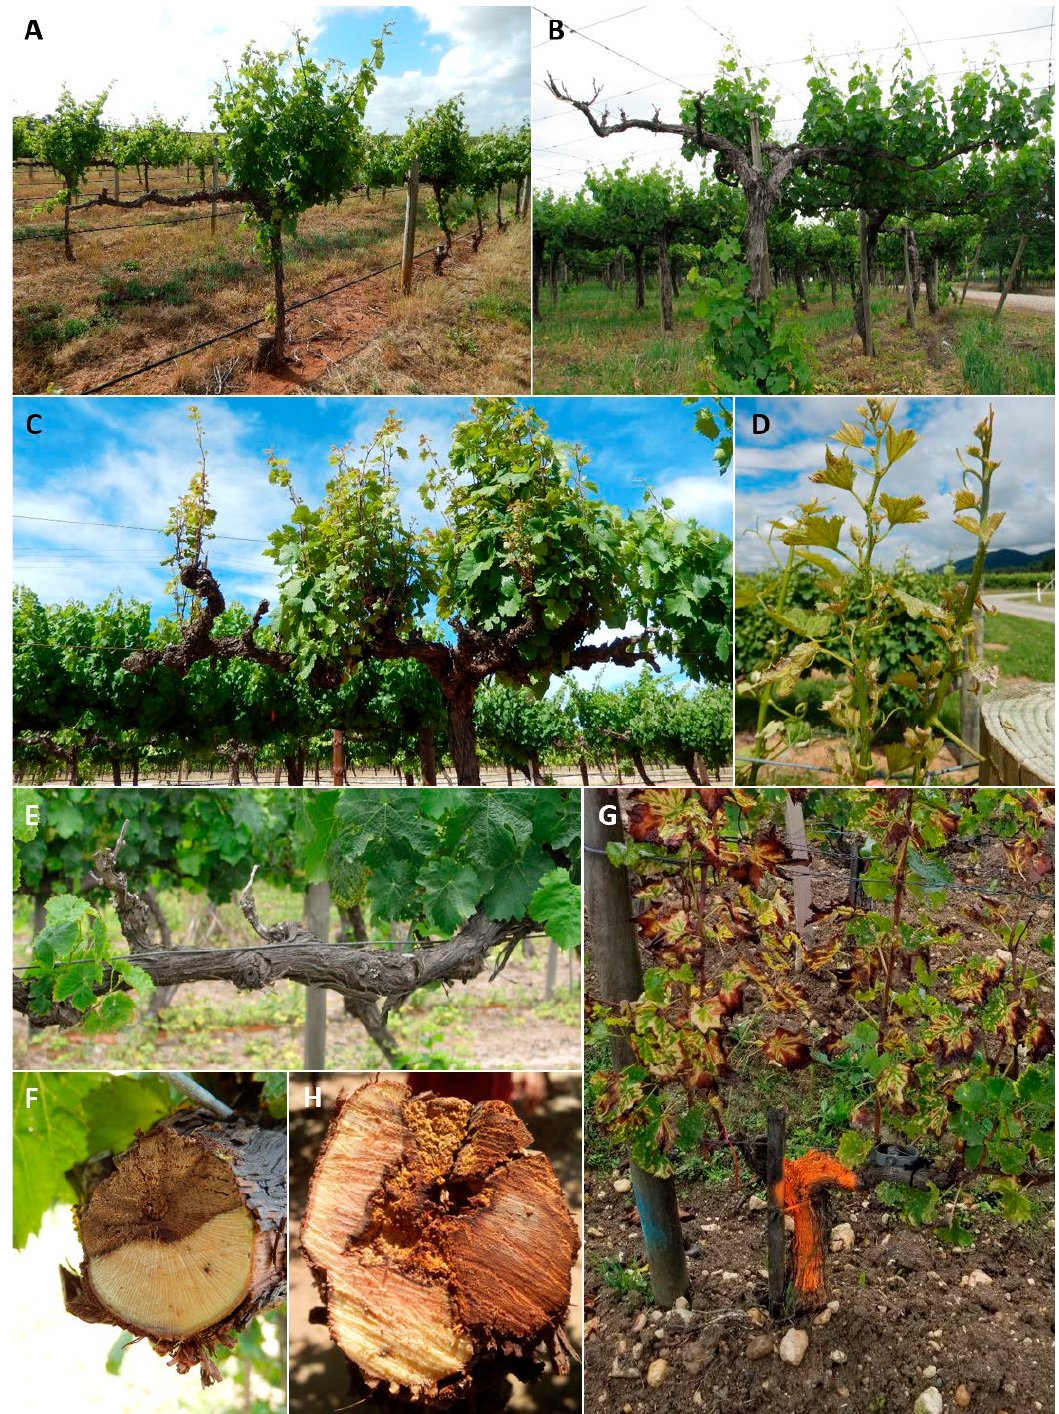
Figure 2. Botryosphaeria dieback, Eutypa, Phomopsis dieback, and Esca symptoms. Botryosphaeria dieback symptoms on wine ( A ) and table grapevines ( B ) are characterized by dead spurs and cordons with no spring growth. Characteristic foliar symptoms of Eutypa dieback are shoots with short internodes and chlorotic and cupped leaves ( C and D ). Phomopsis dieback symptoms resemble those of Botryospha- eria dieback, with dead spurs and lack of spring growth ( E ). Vines affected by Botryosphaeria, Eutypa and/or Phomopsis dieback have per- ennial cankers in spurs, cordons and trunks, often with wedge shapes ( F ). Tiger-striped leaves ( G ) and characteristic soft yellowish wood rot ( H ) caused by Basidiomycete fungi are commonly associated with Esca